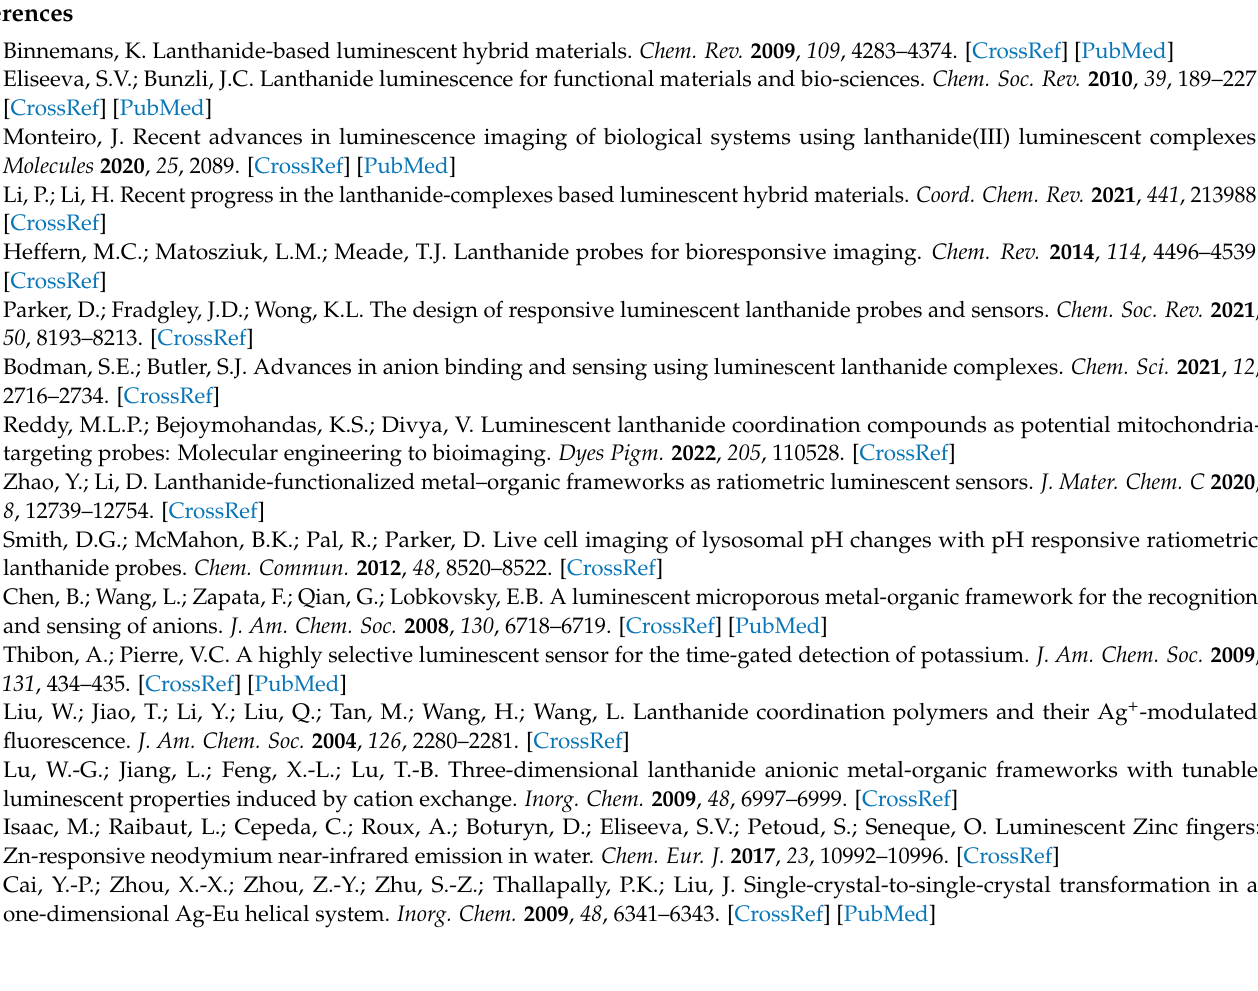
Figure S8: The MALDI-TOF of compound 1 . Figure S9: The ESI-MS of compound 1 in DMF solution after addition of Al 3+ ions. Figure S10: The ESI-MS of compound 2 in DMF solution. Figure S11: The luminescent emission spectra of ligand H 2 TEBA in DMF solution with an emission peak at 340 nm. Figure S12: The luminescent emission spectra of compound 2 in DMF solution with a main emission peak at 346 nm. Figure S13: The excitation spectra of ligand H 2 TEBA, compound 1 and compound 2 in DMF solution observed at their highest emission peak,